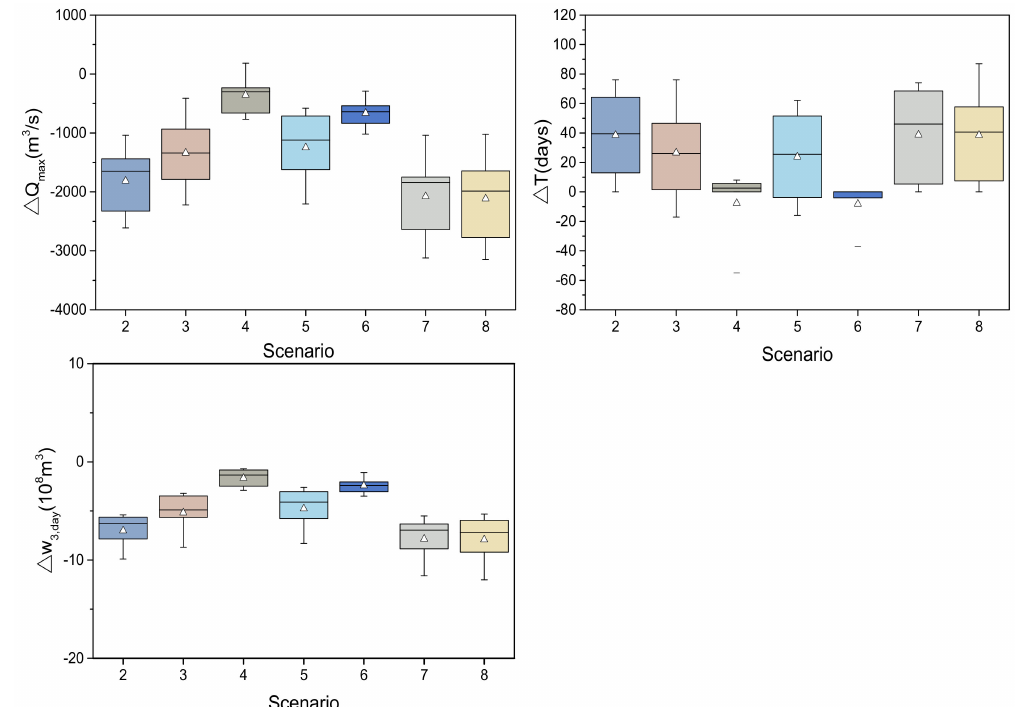
Figure 10. Boxplot of the annual outputs of flood characteristics in 7 Scenarios (2009–2016), where (cid:52) represents the mean, and the horizontal lines of the box, from top to bottom, represent the maximum, upper quartile, median, lower quartile, and